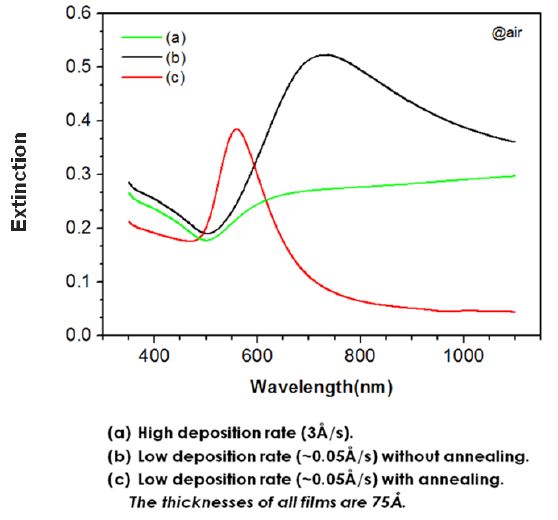
Figure 1. Extinction spectra of gold films obtained from different processes.